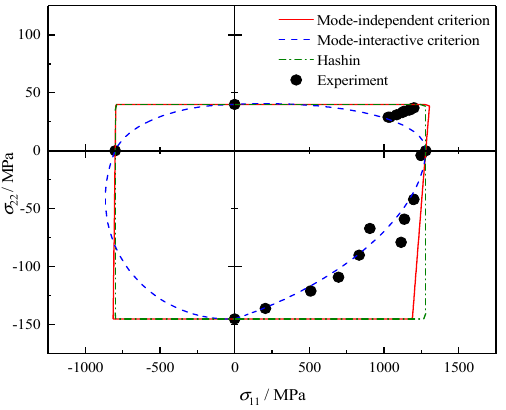
Figure 2. Failure envelopes and experimental results under σ 11 − σ 22 for E-glass /